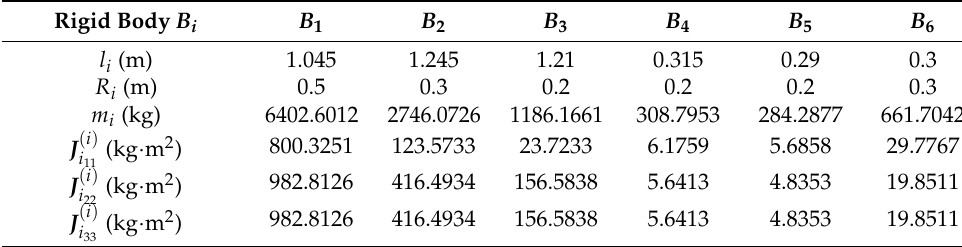
Table 1. Physical parameters of each rigid body. Rigid Body B i B